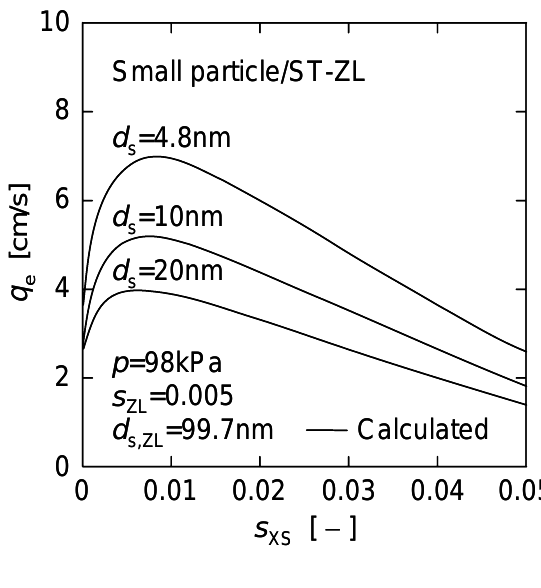
Figure 12. Relations between steady filtration rate and small particle concentration for different small particle